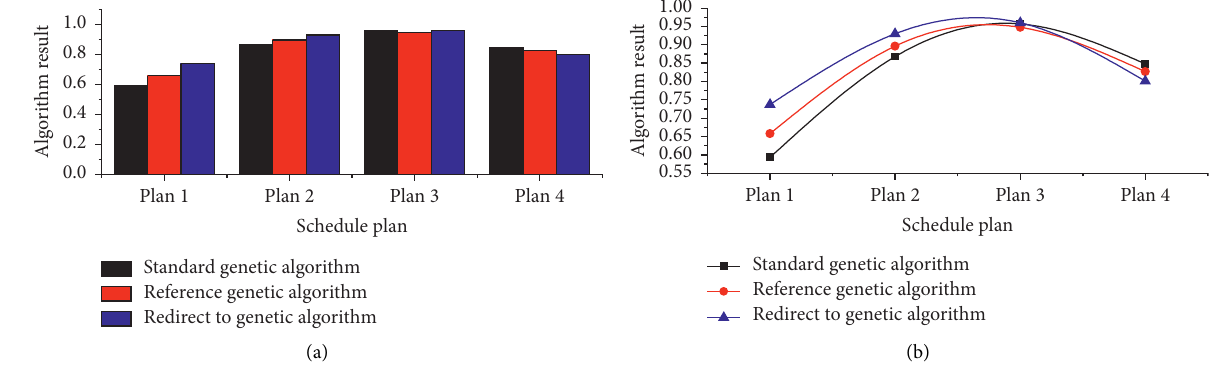
Figure 8: Value of the fitness function considered from the teacher’s